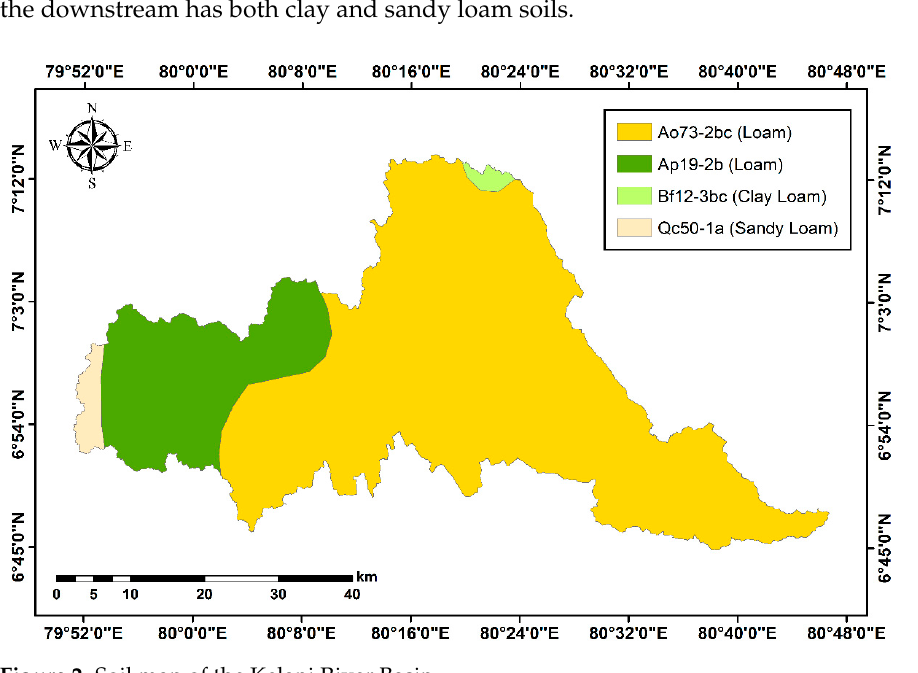
Figure 2. Soil map of the Kelani River